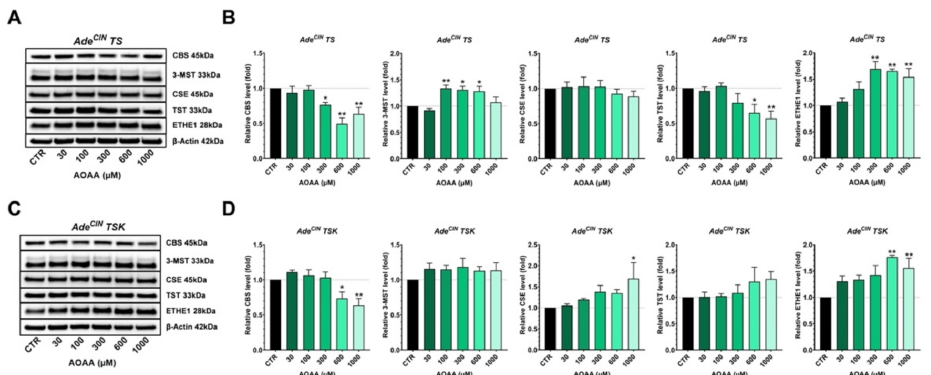
Figure 8. Effect of pharmacological inhibition of CBS/CSE on the expression of various H 2 S- producing and -metabolizing enzymes in Ade CIN TS and Ade CIN TSK organoids . ( A , B ) Western blot analysis of H 2 S-producing and H 2 S-metabolizing enzymes in Ade CIN TS in the presence of increasing concentrations of AOAA for 48 h. ( C , D ) Western blot analysis of H 2 S-producing and -metabolizing enzymes in Ade CIN TSK in the presence of increasing concentrations of AOAA for 48 h. Data represent mean ± SEM of at least 4 independent experiments. CBS refers to the 45 kDa, truncated form, which was the CBS isoform predominantly present in these organoids. * p < 0.05, ** p < 0.01 compared to control.